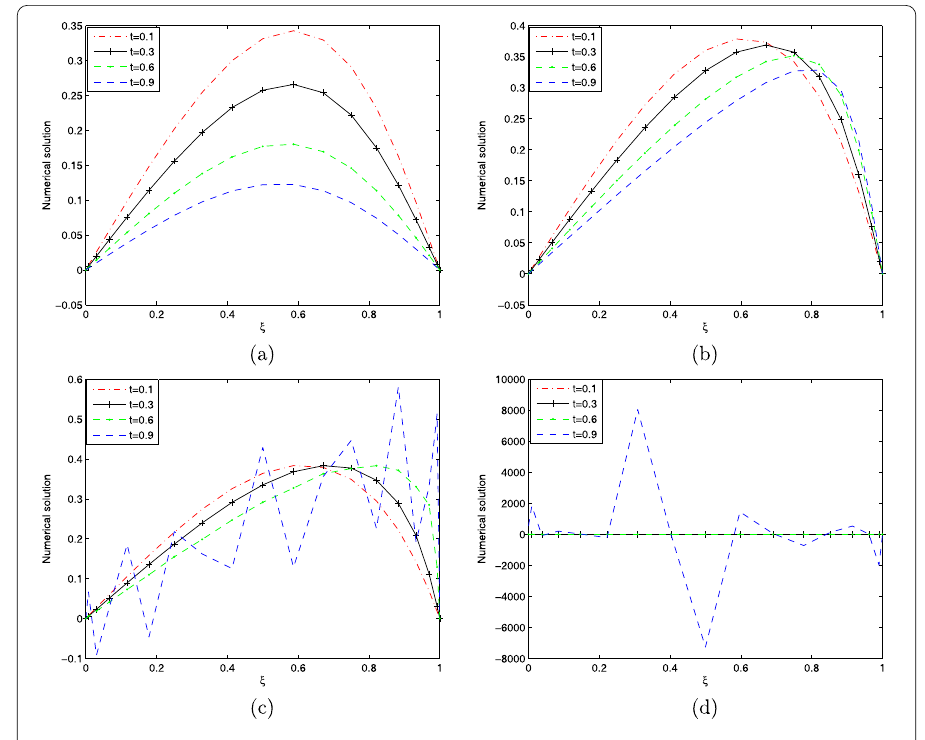
Figure 2 Approximate solutions of Example 4: ( a ) solution of β = 2 –3 with ρ ( M ) < 1, ( b ) solution of β = 2 –6 with ρ ( M ) < 1, ( c ) solution of β = 2 –9 with ρ ( M ) = 1.003, and ( d ) solution of β = 2 –11 with ρ ( M ) =